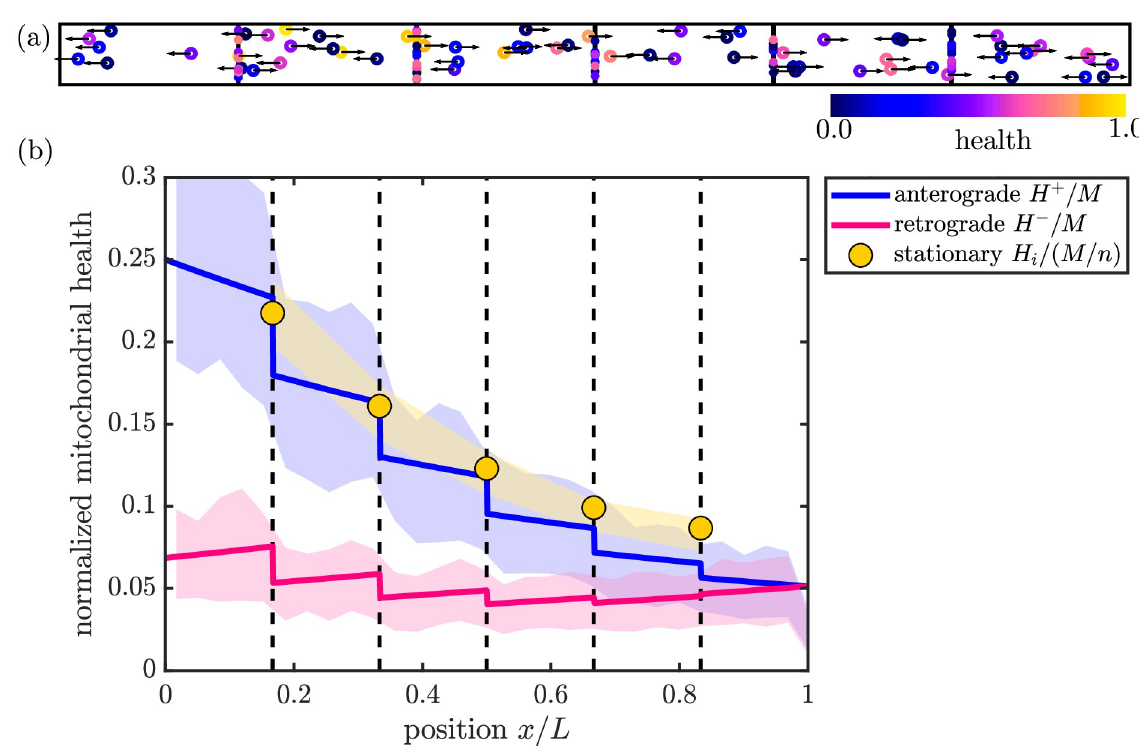
Fig 2. Comparison of mean-field and discrete stochastic models. (a) Snapshot of stochastic simulation of the CoG model, with M = 100. (b) Steady-state solution for mitochondrial health in the CoG model (Eq 2). Solid curves show linear density of mitochondrial health in anterograde (blue) and retrograde (magenta) mitochondria, normalized by total number of mitochondria in the domain. Yellow circles show total health at each of the discrete demand sites (dashed black lines), normalized by the total number of mitochondria per region. Shaded regions show corresponding quantities from discrete stochastic simulations (mean ± standard deviation) with M = 1500 mitochondria in the domain. Parameters used in (a) and (b): n = 5, p s = 0.4, f s = 0.5, k d L / v = 0.6. Corresponding results for the SS model are provided in S1